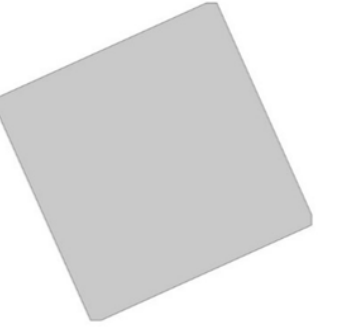
Figure 1. The first stage of the process of obtaining the cell: defining the dimensions of the cut-out triangle.